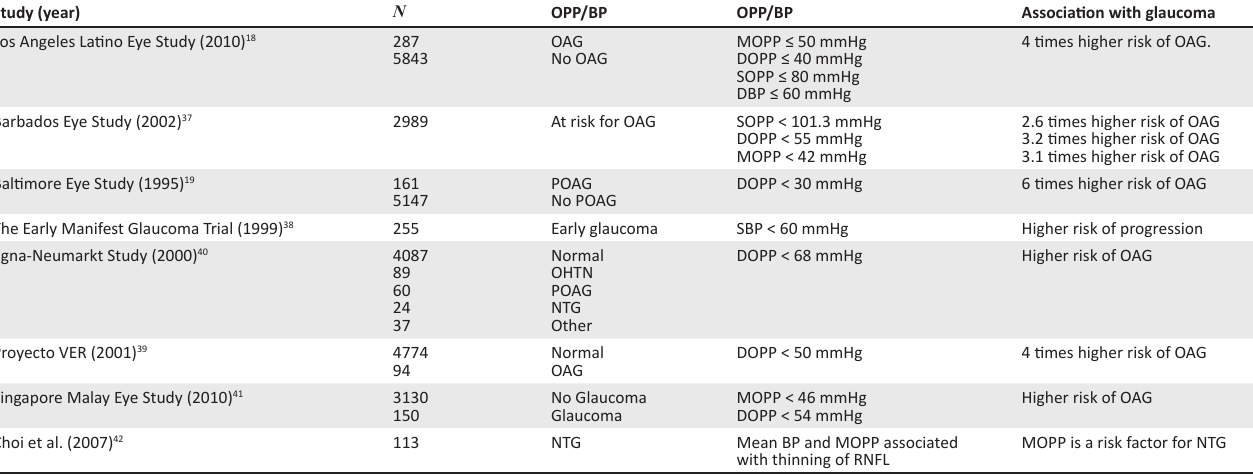
TABLE 2: Ocular perfusion pressure and blood pressure and their association with glaucoma. Study